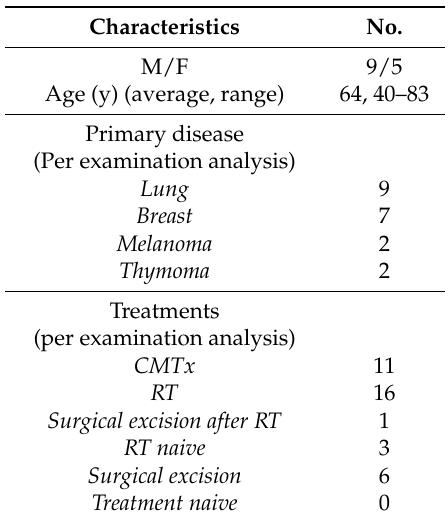
Table 1. Patients’ characteristics: M: Male, F: Female, No.: number, y: years old, CMTx: chemotherapy, RT: radiotreatment in the brain, RT naive: refer to patients who never had undergone radiotreatment in the brain. In one case the patient had undergone surgical excision after radiotherapy and is mentioned separately. Surgical excision refers to all patients who had surgical excision of a brain lesion. Treatment naive refers to patients who had never undergone neither chemotherapy nor radiotreatment. Per examination analysis refers to the number of 18F-FLT-PET/CT